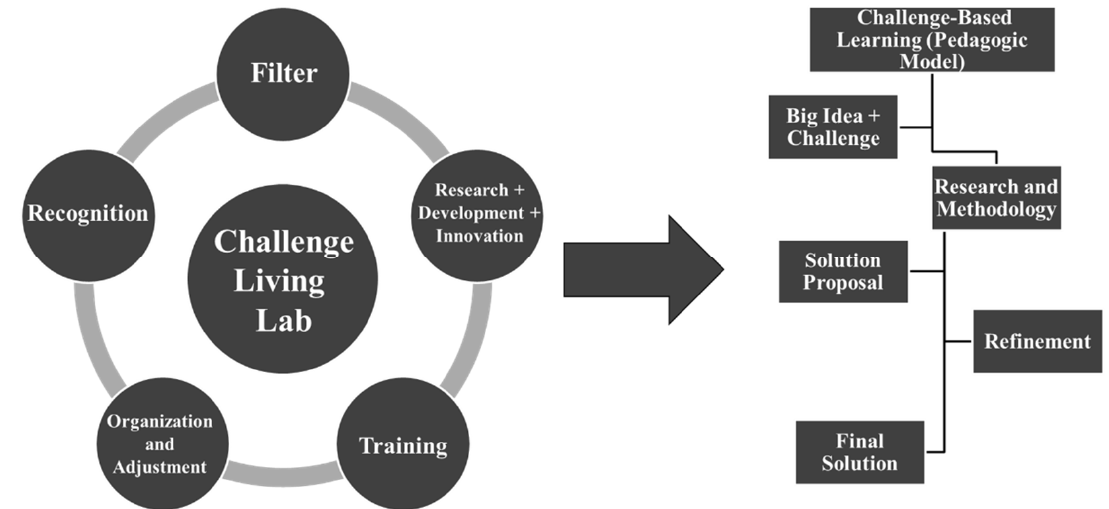
Figure 4. Campus City Challenge Living Lab virtuous loop and Challenge-Based Learning pedagogic methodology.